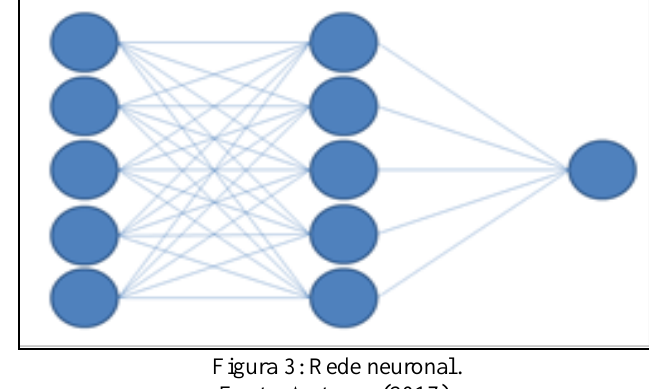
Figura 3: Rede neuronal. Fonte: Autores,